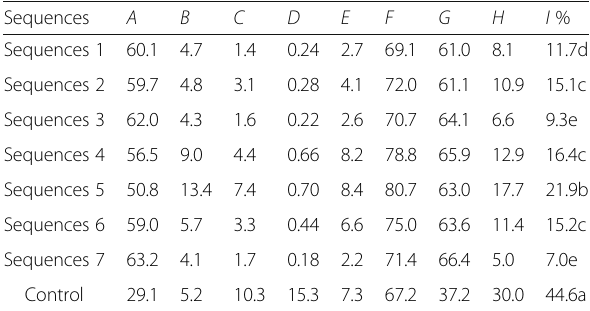
Table 7 Assessment of loss due to bollworms in different sequence treatments during season 2017